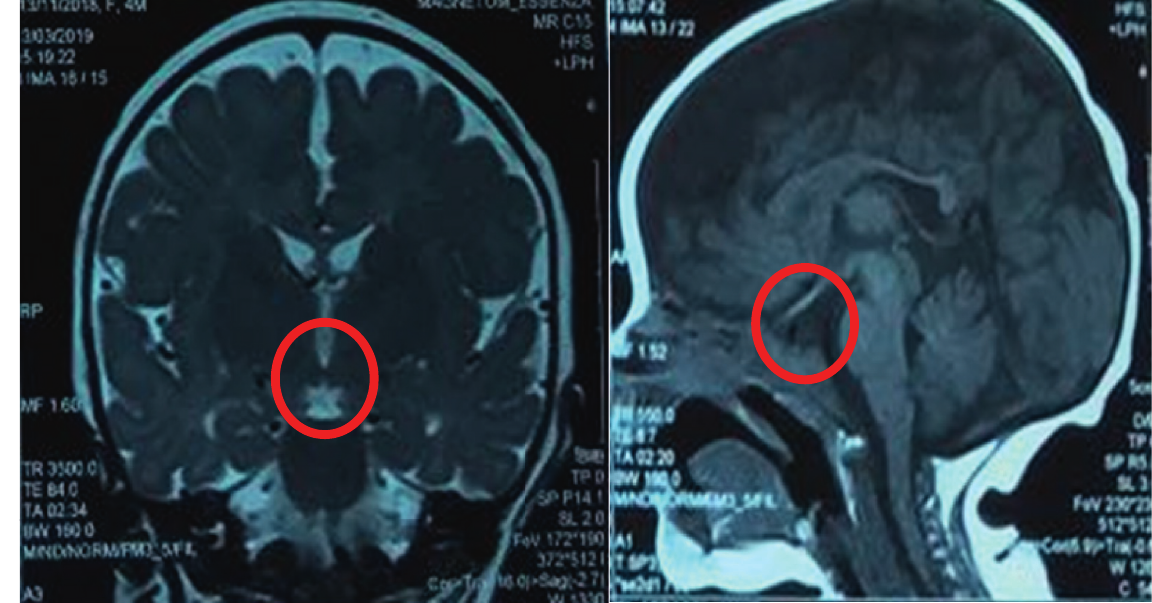
Figure 1: MRI of the head revealed a small anterior pituitary gland, an invisible stalk, and an ectopic posterior lobe.